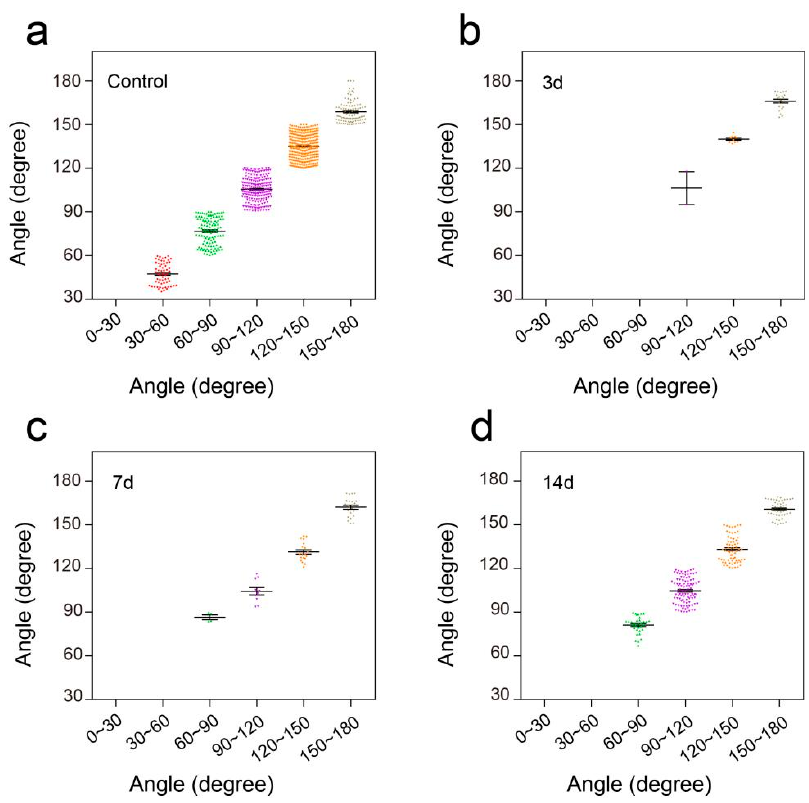
Figure 10. Distribution of ankle angle in swimming. ( a ) Ankle angle distribution of the control group. ( b ) Ankle angle distribution of unilateral thoracic SCI 3d mice. ( c ) Ankle angle distribution of unilateral thoracic SCI 7d mice. ( d ) Ankle angle distribution of unilateral thoracic SCI 14d mice.